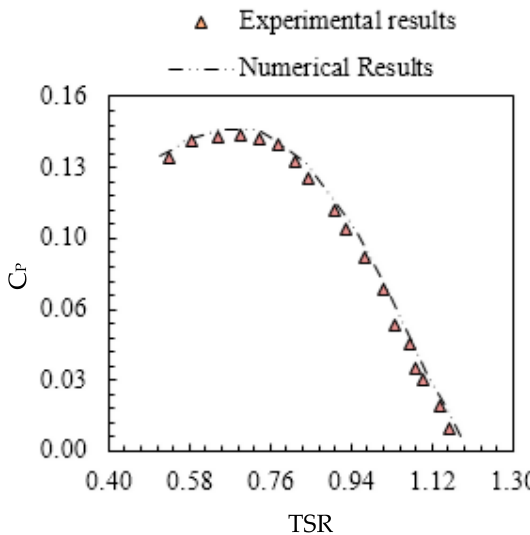
Figure 10. Power coefficient validation.